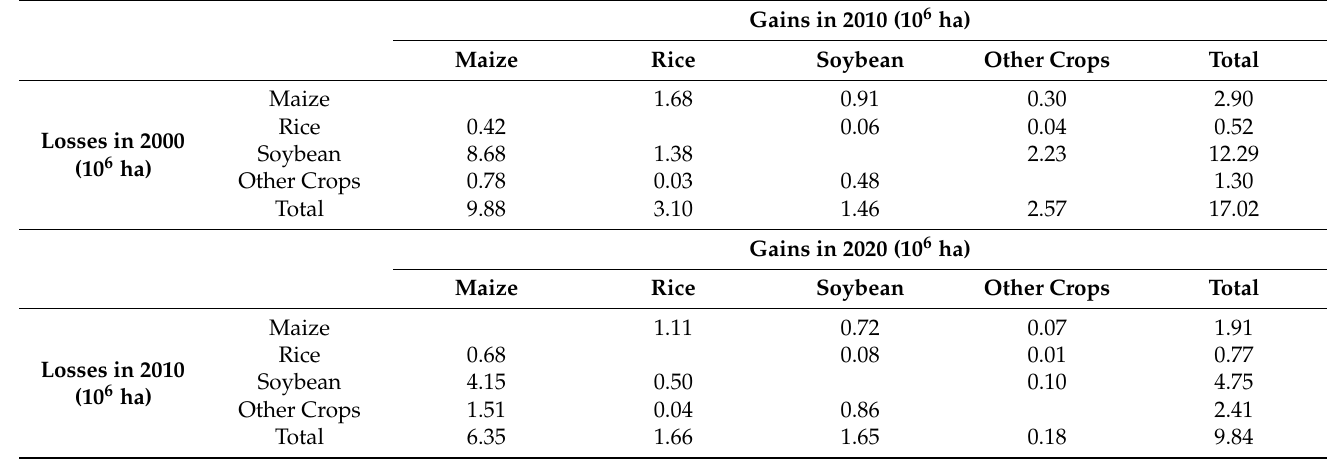
Table 3. Conversion matrix of crop types in the NEC from 2000 to